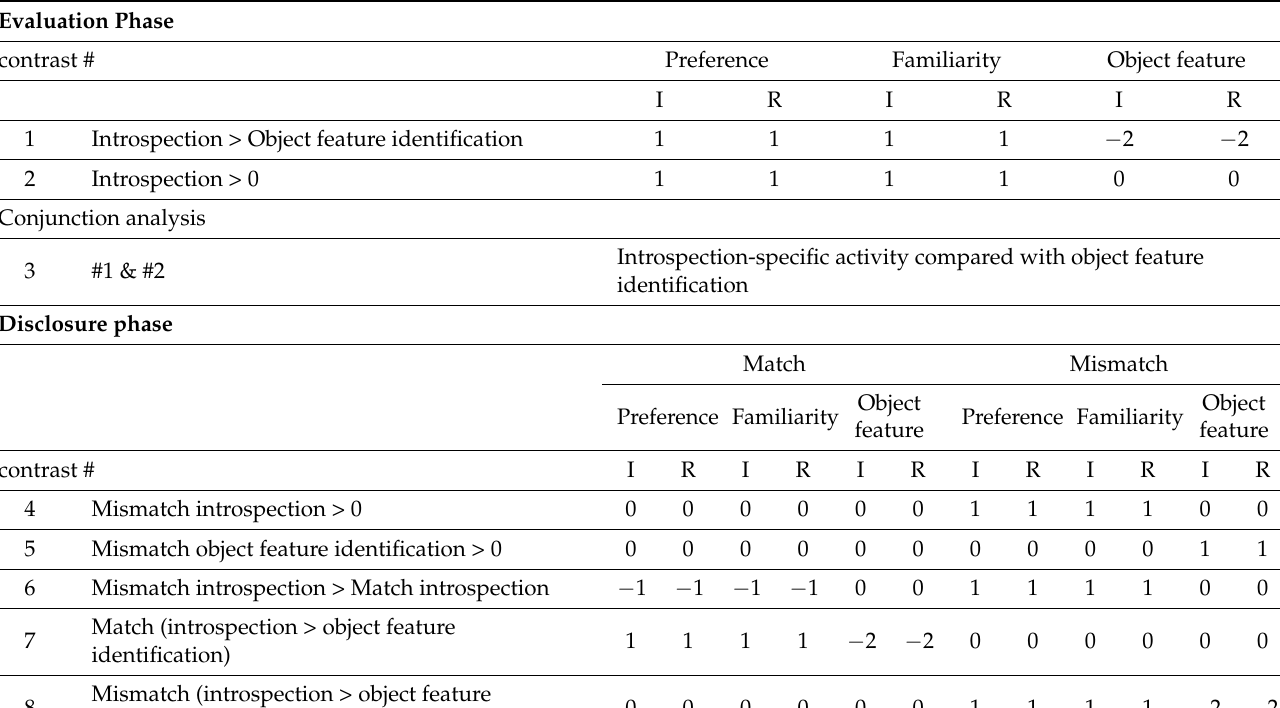
Table 1. Predefined contrasts of the evaluation phase and disclosure phase